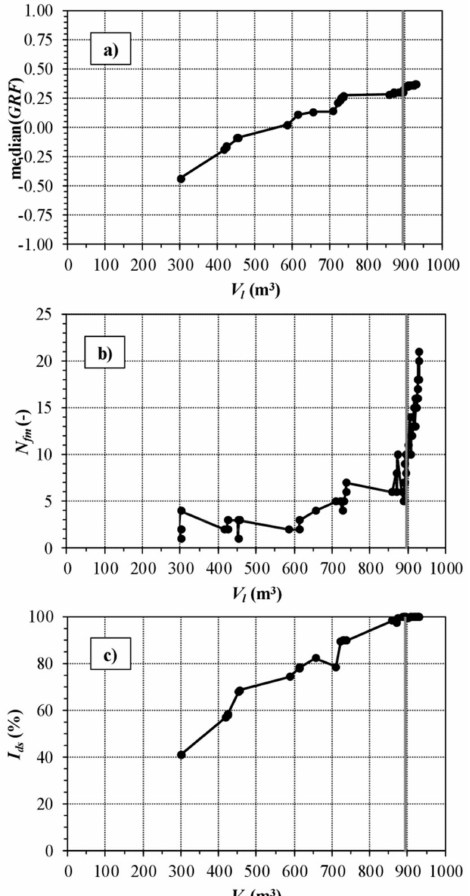
Figure 1. Dividing phase considering the clustered graph of the Parete WDN (Variant 1). Pareto front of optimal solutions in the trade-o ff between daily median ( GRF ) index and leakage volume V l ( a ), re-evaluated solutions in terms of number of flow meters N fm ( b ), and of demand satisfaction rate I ds ( c ). In all graphs, the selected solution is highlighted with a grey vertical